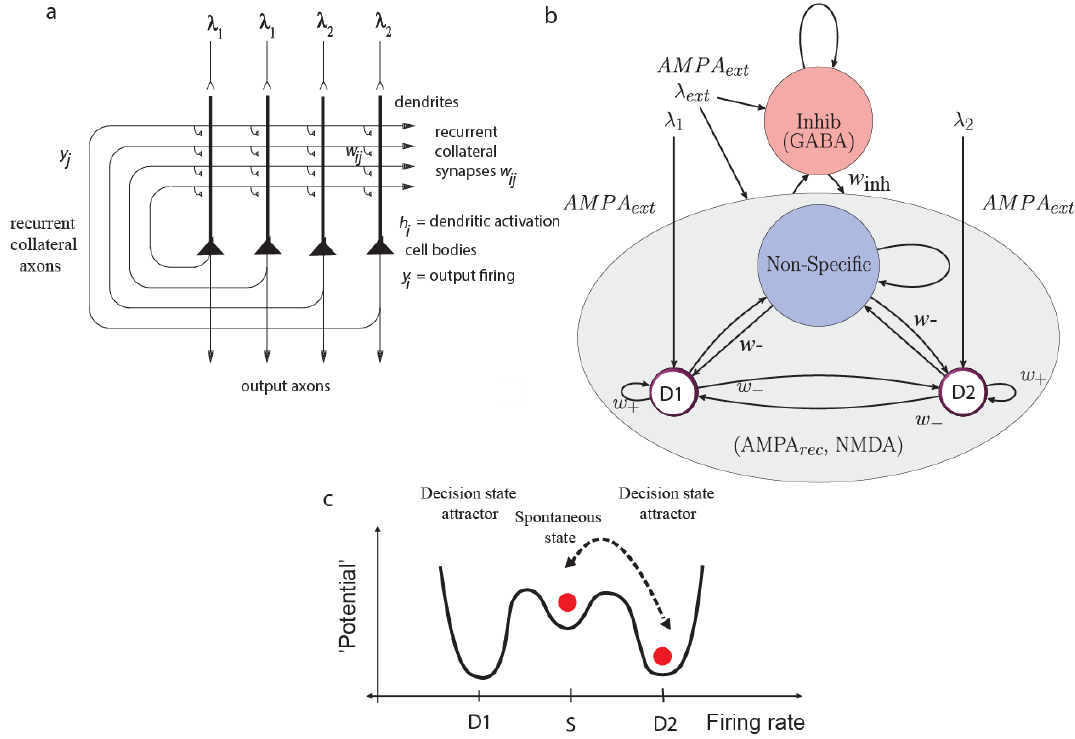
Figure 3 : (a) Attractor or autoassociation single network architecture for decision-making. The cell body of each neuron is shown as a triangle (like a cortical pyramidal cell), the dendrite is vertical, and receives recurrent collateral synaptic connections w from the other neurons. The evidence for decision 1 is applied via the λ 1 inputs, and for ij have been associatively modified during training in the decision 2 via the λ 2 inputs. The synaptic weights w ij presence of λ 1 and at a different time of λ 2 . When λ 1 and λ 2 are applied, each attractor competes through the inhibitory interneurons (not shown), until one wins the competition, and the network falls into one of the high firing rate attractors that represents the decision. The noise in the network caused by the random spiking of the neurons means that on some trials, for given inputs, the neurons in the decision 1 (D1) attractor are more likely to win, and on other trials the neurons in the decision 2 (D2) attractor are more likely to win. This makes the decision-making probabilistic, for, as shown in (c), the noise influences when the system will jump out of the spontaneous firing stable (low energy) state S, and whether it jumps into the high firing state for decision 1 (D1) or decision 2 (D2). (b) The architecture of the integrate-and-fire network used to model decision-making (see text). (c) A multistable “effective energy landscape” for decision-making with stable states shown as low “potential” basins. Even when the inputs are being applied to the network, the spontaneous firing rate state is stable, and noise provokes transitions into the high firing rate decision attractor state D1 or D2 (see Rolls and Deco